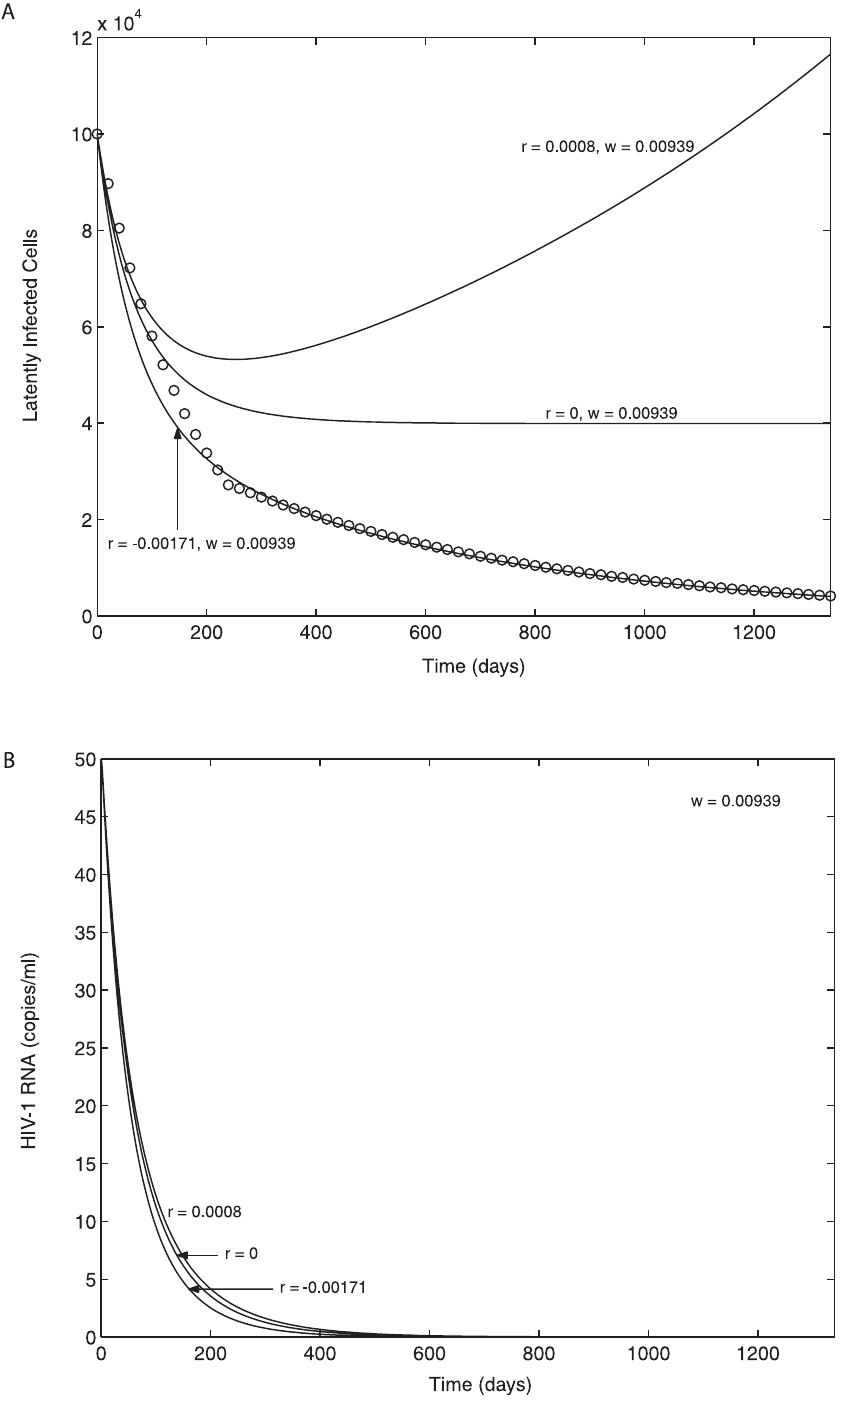
Figure 2. Effect of the Bystander Proliferation of the Latent Reservoir on the Latent Reservoir and on Plasma Viral Load When there is no ongoing viral replication ( e ¼ 1) and the minimum activation rate of the latent reservoir is zero ( a min ¼ 0). The open circles indicate the decay kinetics of the latent reservoir suggested by Strain et al. [30], where they found t 1/2 ’ 18 wk up to week 35 and t 1/2 ’ 58 wk for the subsequent 3 y. The solid curve with r ¼(cid:1) 0.00171 d (cid:1) 1 and x ¼ 0.00939 d (cid:1) 1 represents the best-fit curve to the data. (A) Latent reservoir. (B) Plasma viral load. DOI: